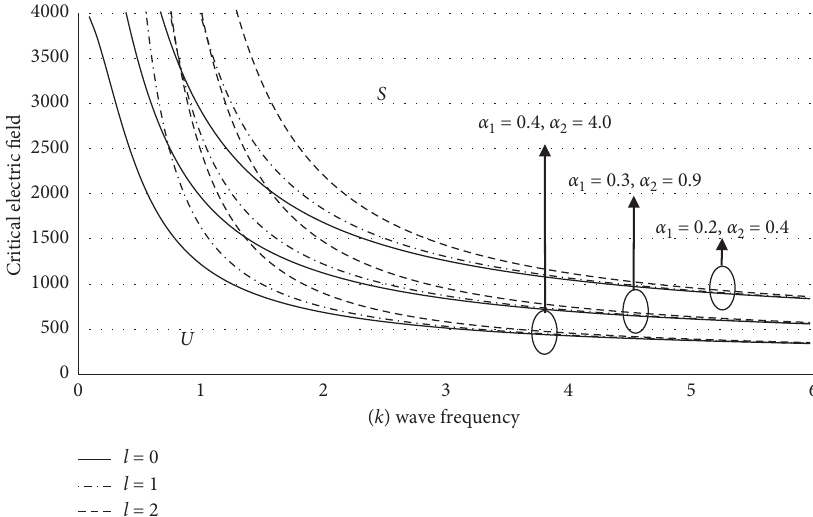
Figure 2: Variation of E 2